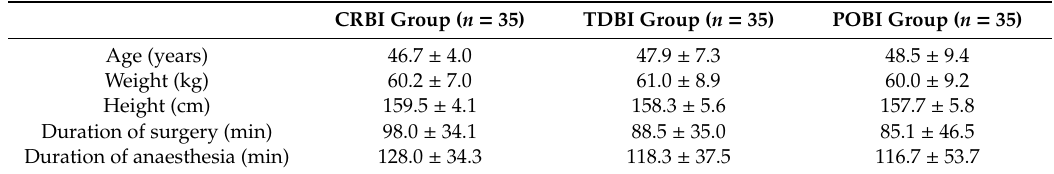
Table 1. Characteristics of patients receiving post-operative anaesthesia, and duration of surgery and anaesthesia. Data are represented as mean ± standard